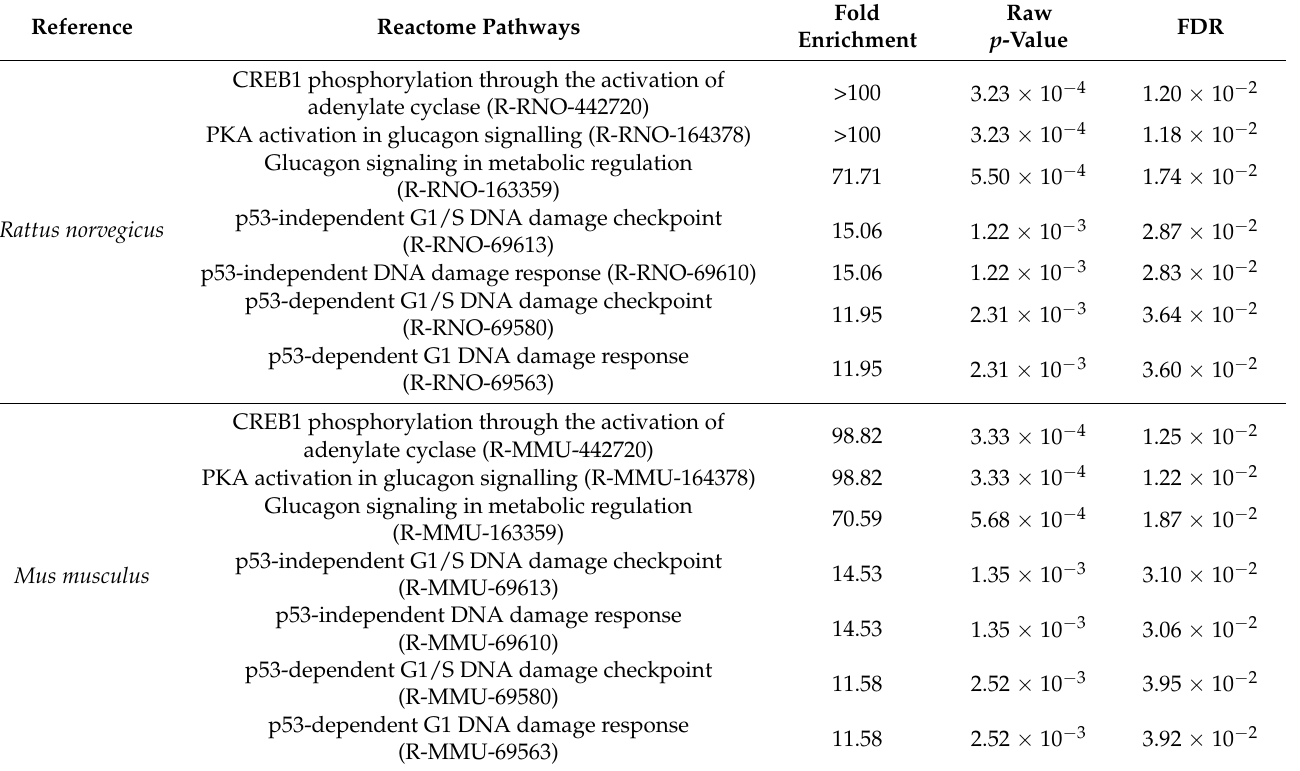
Table 2. The tumorigenesis-associated Reactome pathways of the differentially expressed proteins that were absent in the PreD